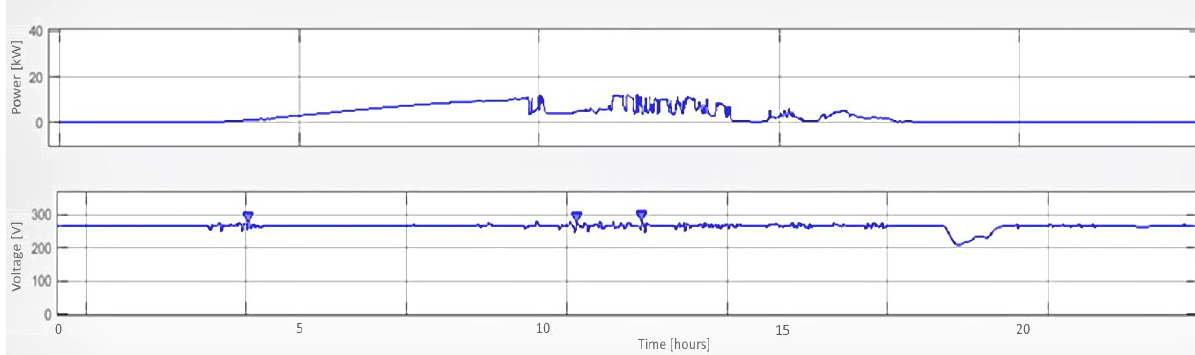
Figure 17. Daily waveform of power and the average voltage at the output of the PV modules (12.2 kW) on a sample day in July.